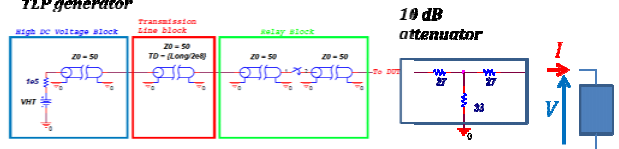
Figure 6: General test setup with TLP generator to perform I/V characteristic measurement.